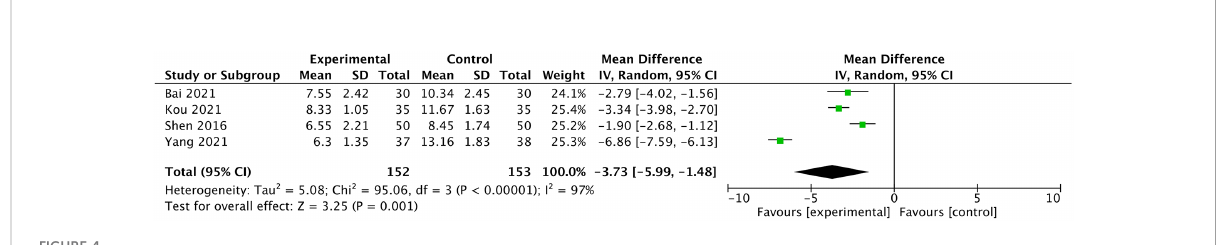
FIGURE 4 Forest plot of the sleep disturbances measured by Pittsburgh Sleep Quality Index in lung cancer patients treated with acupuncture and